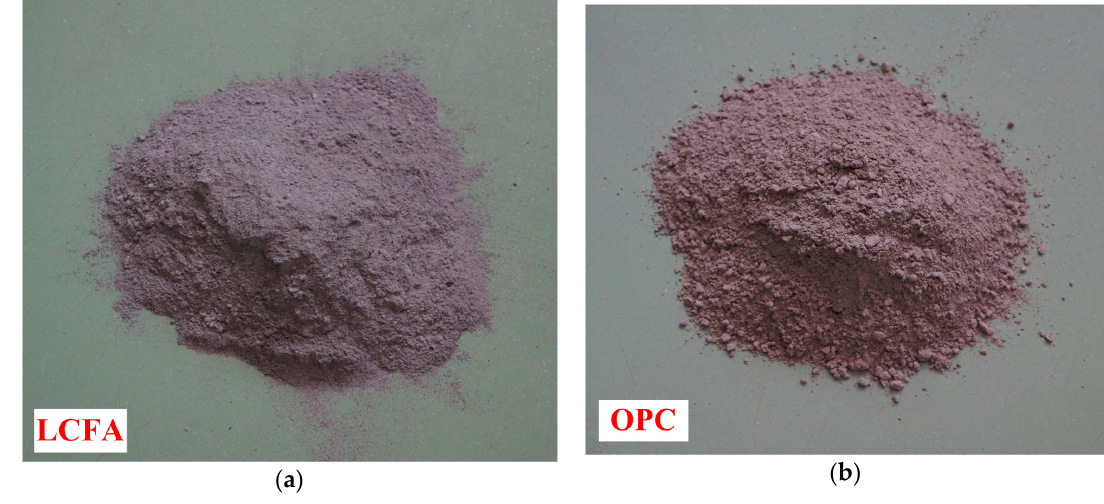
Figure 2. Apperance of the binders: ( a ) LCFA; ( b ) Ordinary Portland Cement (OPC).